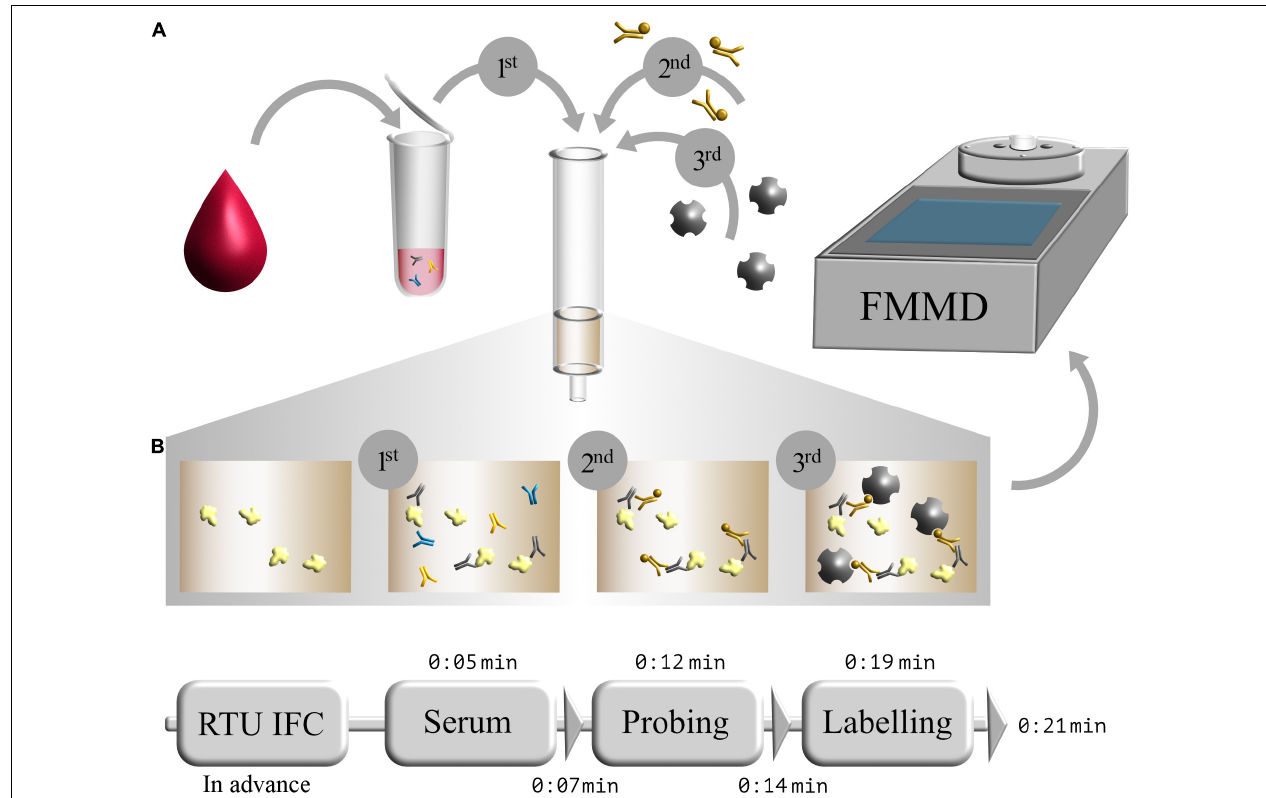
FIGURE 3 | Schematic workflow of serological magnetic immunodetection for detection of SARS-CoV-2-specific antibodies in human serum. (A) Initial application of human blood or serum onto SARS-CoV-2 S1-antigen precoated and blocked ready-to-use immunofiltration column (IFC; 1); sample is 40-fold prediluted. Following retention of antigen-specific antibodies within the matrix, IFC is washed and loaded with biotinylated human IgG-specific secondary antibody (2). Subsequently, IFC is washed again, and streptavidin-functionalized magnetic particles were applied (3), resulting in a magnetic labeling of bound antibody complex. Finally, IFC is washed again, and enriched magnetic particles were sensed by means of frequency magnetic mixing detection (FMMD) technology. (B) Chronological overview of magnetic immunodetection assay duration, starting with ready-to-use immunofiltration columns (RTU-IFCs), which can be coated and blocked in advance. For analysis of SARS-CoV-2-specific antibody occurrence in human serum, prediluted serum is applied and incubated for 5 min (Serum), followed by an subsequent washing step of 2 min (depicted as triangle). Afterward, biotinylated human IgG-specific secondary antibody is applied (Probing) and incubated for additional 5 min prior another 2 min washing step. Finally, magnetic beads are applied (Labeling), incubated for 5 min and washed for 2 min, resulting in an assay duration of in total 21 min. FMMD readout takes only about 10